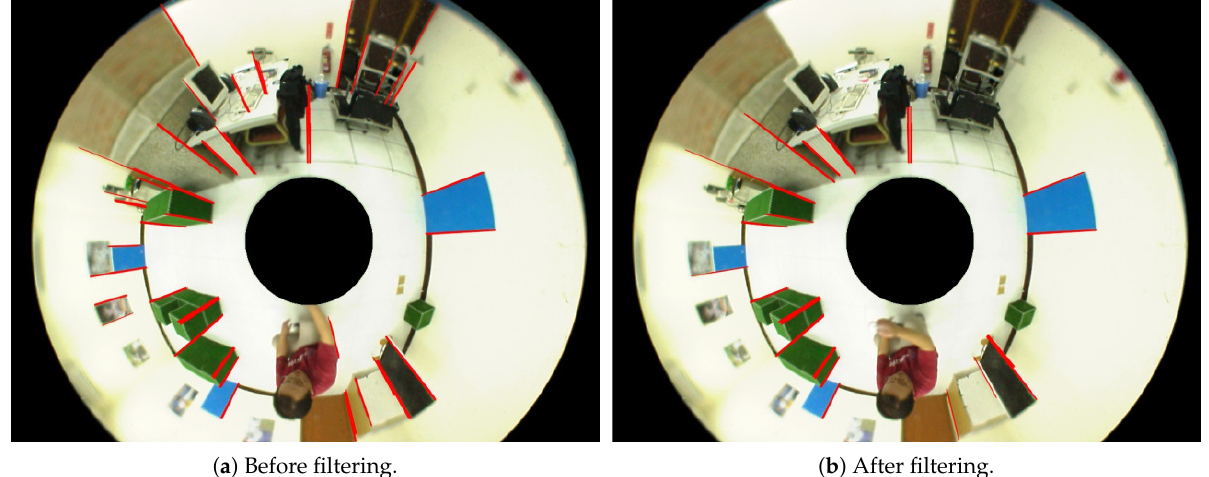
( a ) Before filtering. Figure 8. The detection of line segments before and after filtering by the ground plane